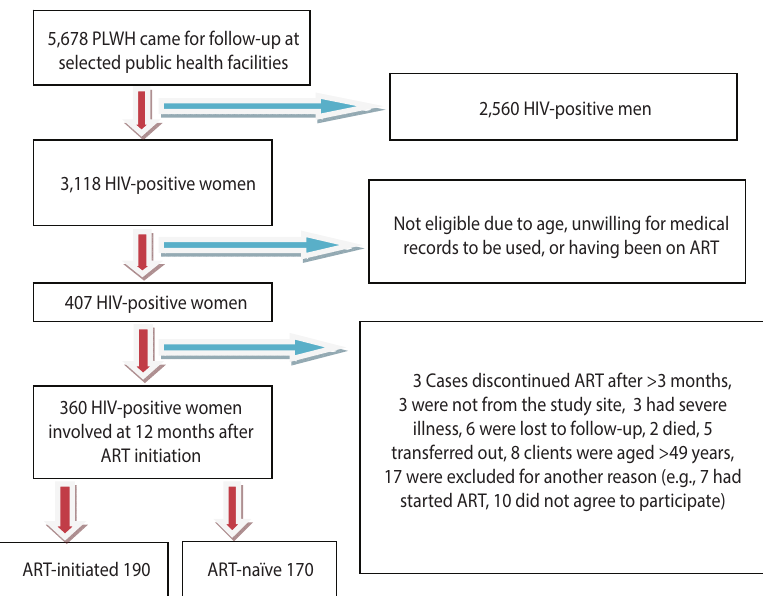
Figure 1. Schematic representation of the enrollment of subjects in Addis Ababa, Ethiopia, 2014. PLWH, person living with HIV; HIV, human immunodeficiency virus; ART, antiretroviral therapy.